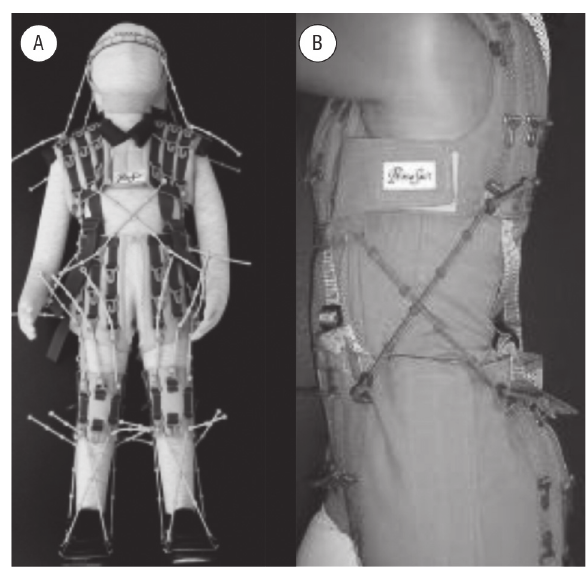
Figure 1 - Suit with its parts: shorts, knee pads and spe- cially adapted shoes with hooks and elastic cords – Coronal plane (A); Sagittal plane (B) Source: Research data.